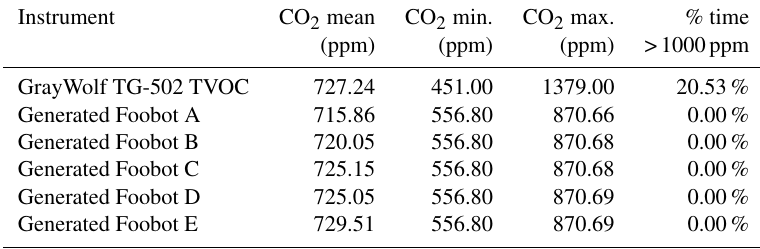
Table 7. Summary statistics for the generated CO 2 from the validation dataset divided by instruments.